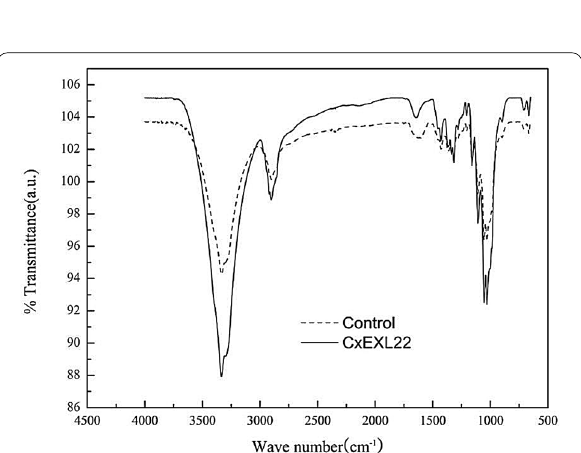
Fig. 5 Comparison of Fourier-transform infrared spectra of Avicel treated with CxEXL22 with that of untreated